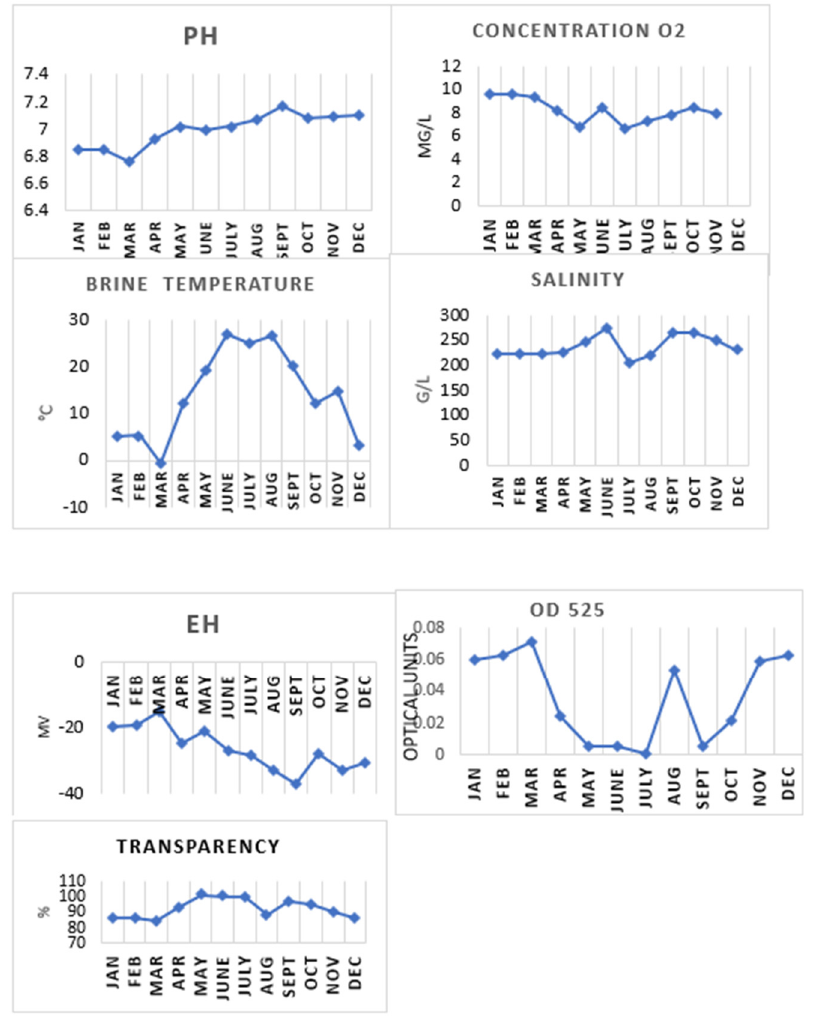
Figure 8. Seasonal dynamics of water physicochemical characteristics. The oxygen content of the water also ranged from 6.68 mg/L in July to 9.65 mg/L in February. No correlation was observed between salinity and oxygen